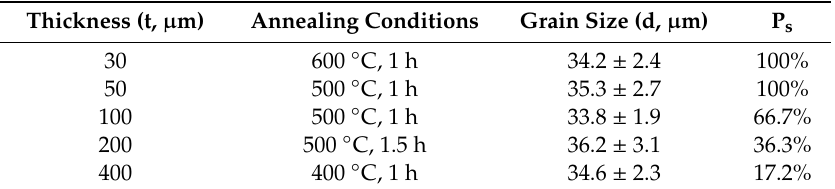
Table 2. Material parameters of experimental CuZn20 foils.